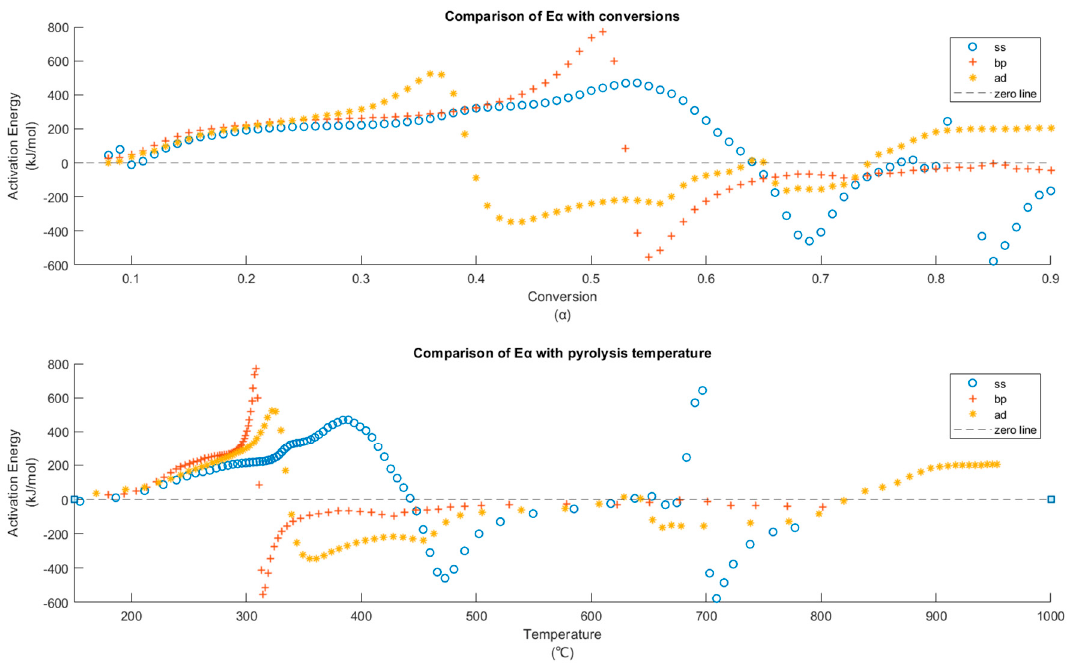
Figure 6. E α vs. α and E α vs. T avg (average temperature at all heating rates) for the three substrates BP, SS and AD.